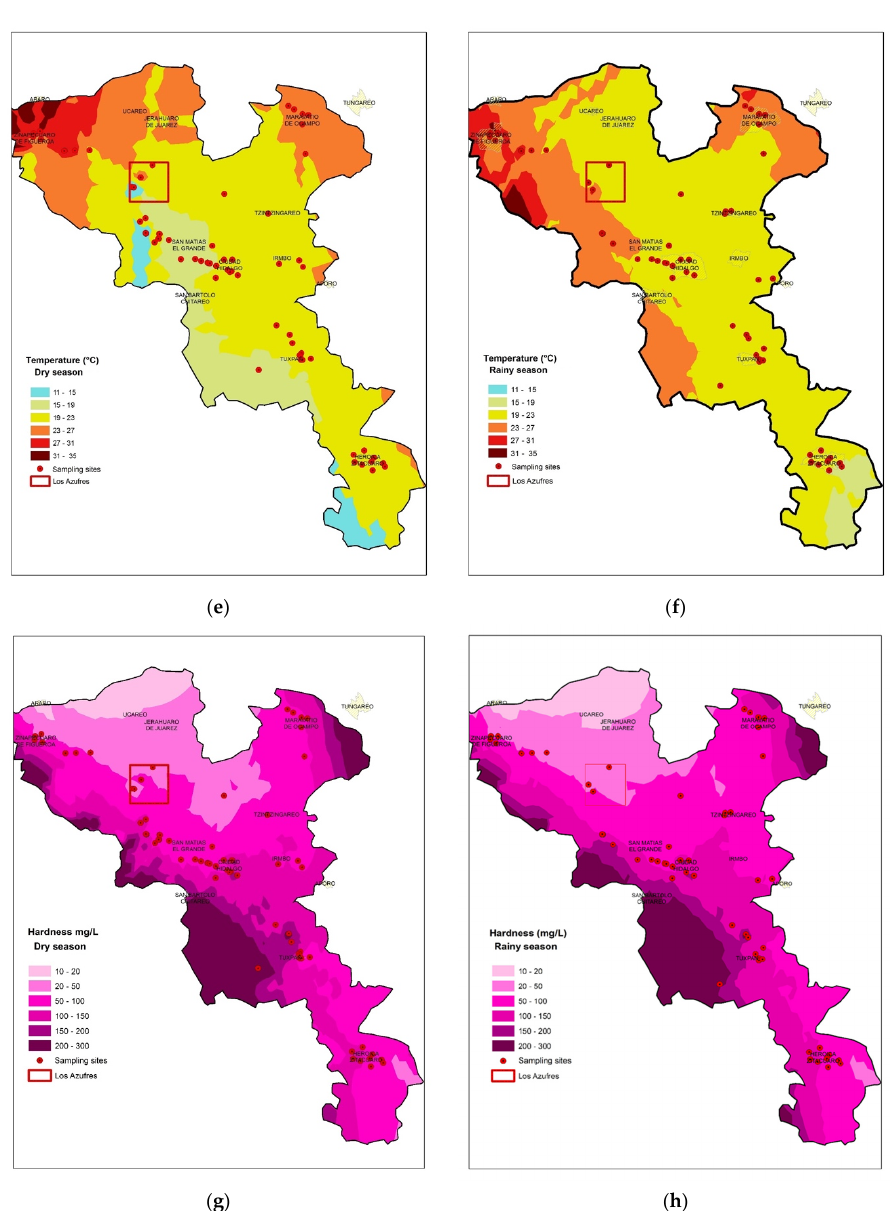
Figure 4. Spatial distribution maps generated by GIS through the kriging spatial interpolation method for both seasons. Here, the possible concentrations or levels of different parameters are observed: Arsenic ( a – b ); pH ( c – d ); temperature ( e – f ); hardness ( g – h ). The geothermic field is displayed in a red box. During the dry season, one part of the area of operation of the geothermic field and its surroundings shows zones with higher concentrations of arsenic (Figure 4a). Some of the communities in the surroundings, Jeráhuaro and Ucareo (both located north of “Los